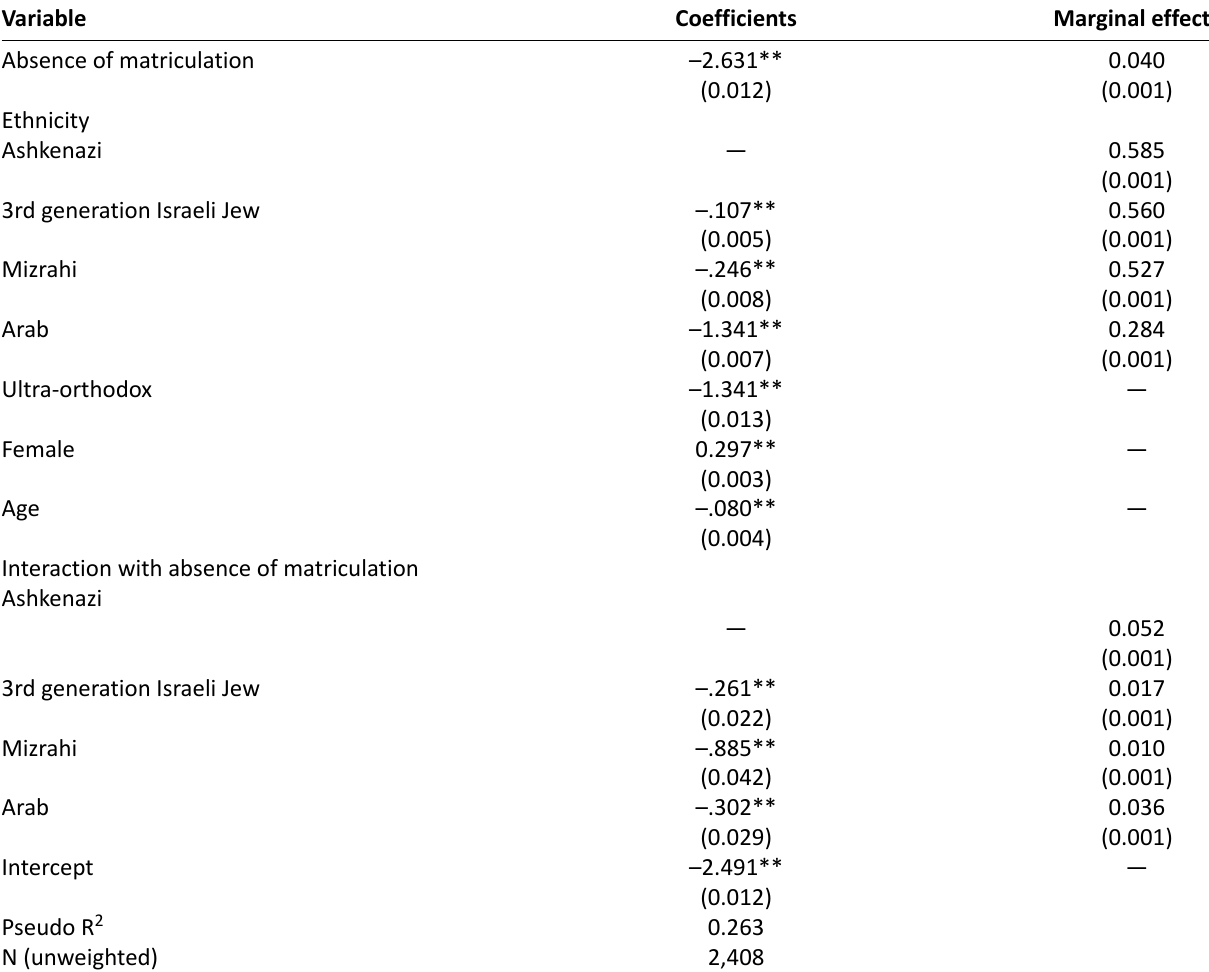
Table 2. Fixed-effects logistic regression for attainment of academic